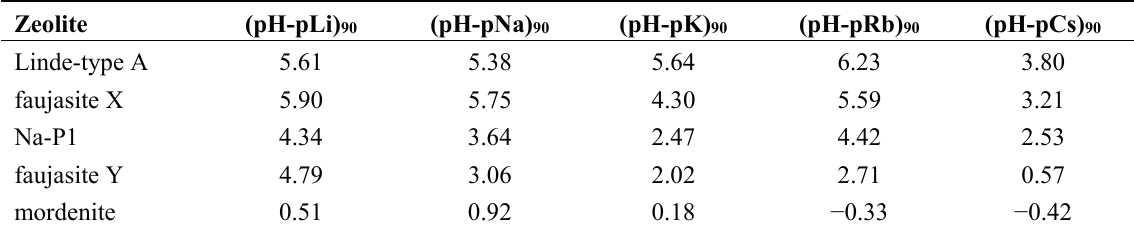
Table 1. Effect of saturation cation of zeolites on (pH-pM) 90 value. Data of (pH-pNa) 90 were cited from a reference